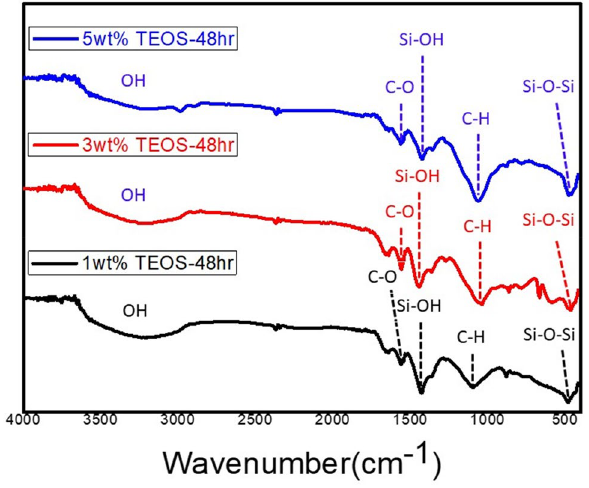
Fig. 4 FTIR spectra of silver powders coated with various amounts of TEOS for a reaction time of 48